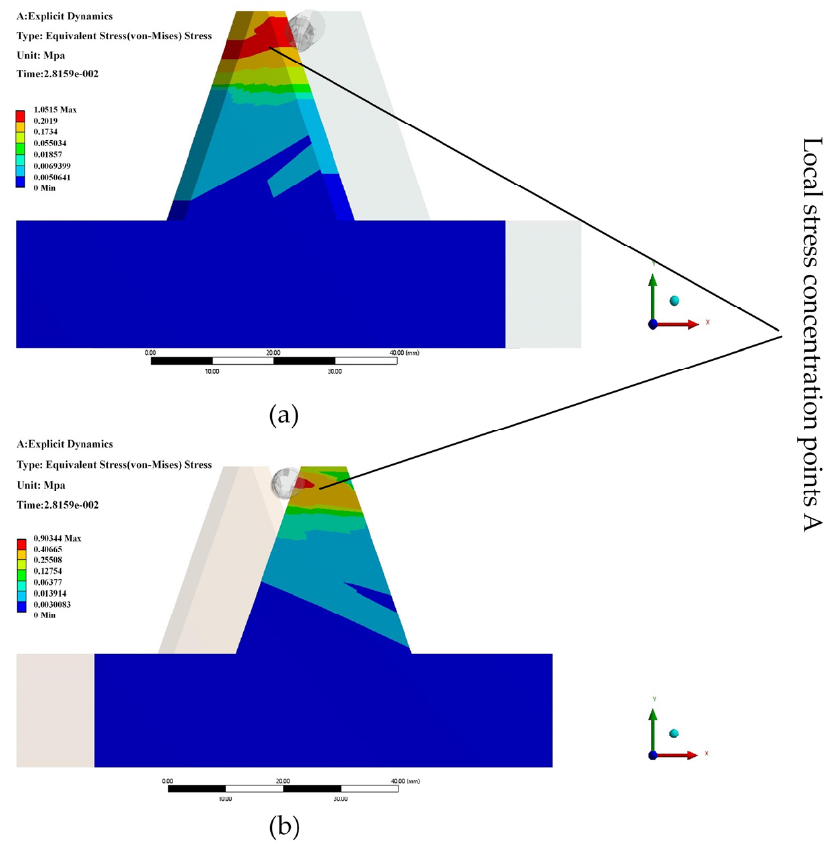
Figure 10. Maximum equivalent stress distribution cloud diagram: ( a ) upper cutting blade; ( b ) bottom cutting blade.